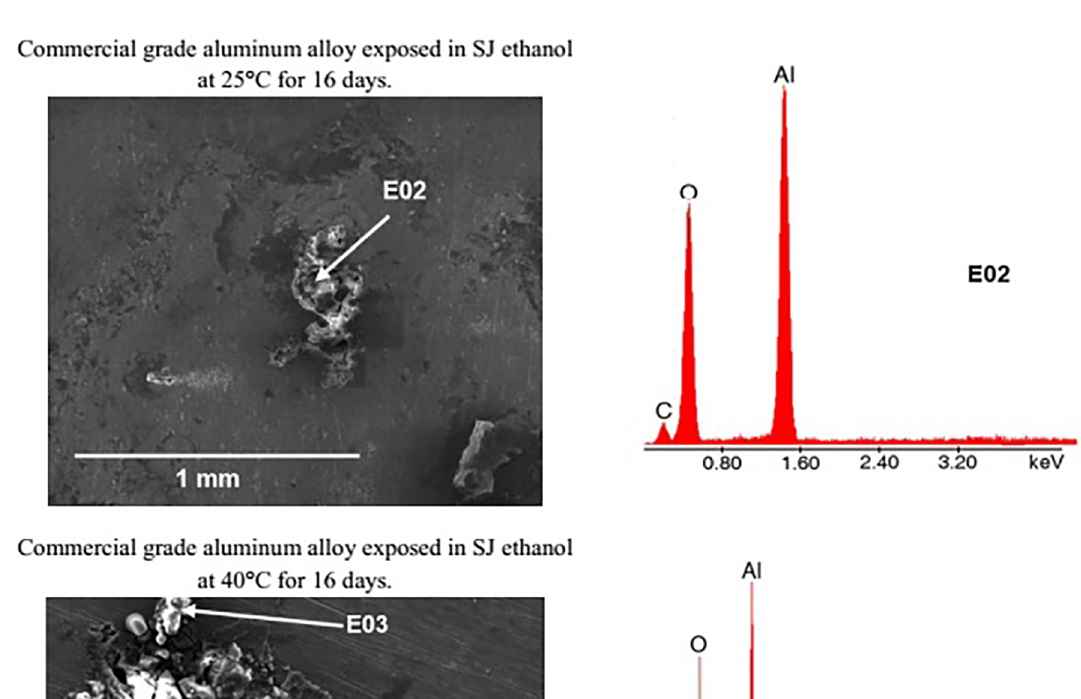
Figure 7. SEM and EDX at different points on the surfaces of the materials after the gravimetric tests.